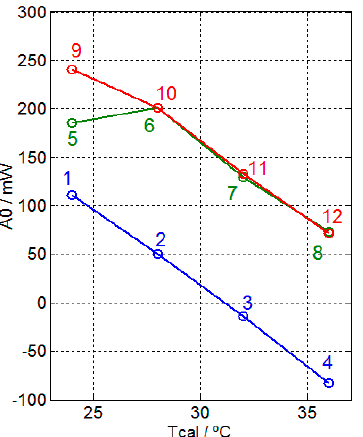
Figure 10. Coefficient A 0 of the heat flux (Equation (5)) of the human body (left hand of a healthy 59-year-old male subject) for different thermostat temperatures ( Tcal ). Measurements made on the same day: 1–4 (morning), 5–12 (afternoon).